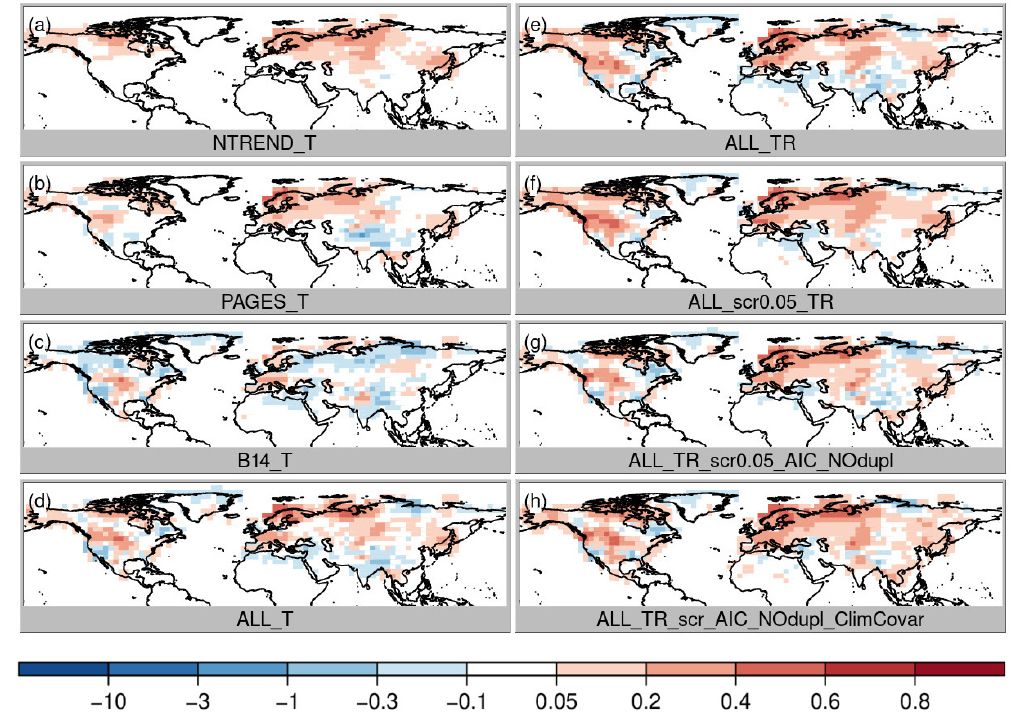
Figure 6. Temperature RMSESS skill score, where red colors indicate an improvement of the